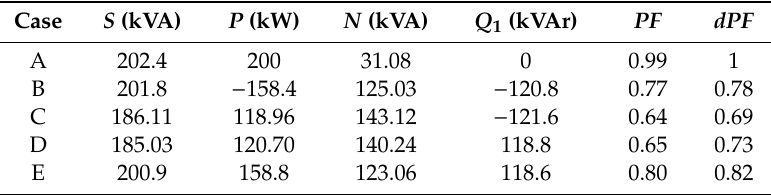
Table 8. Power terms according to Standard